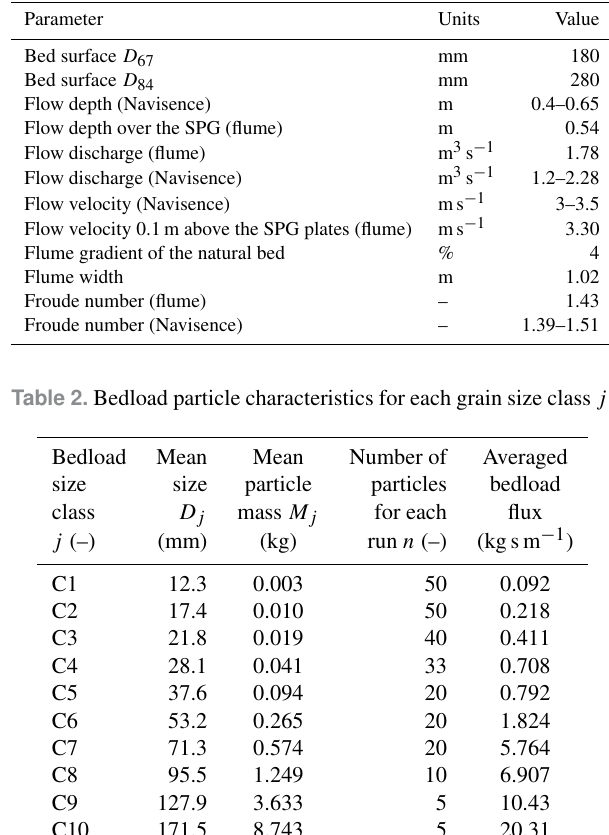
Table 1. Bed and flow conditions at the Navisence field site and in the flume experiments.